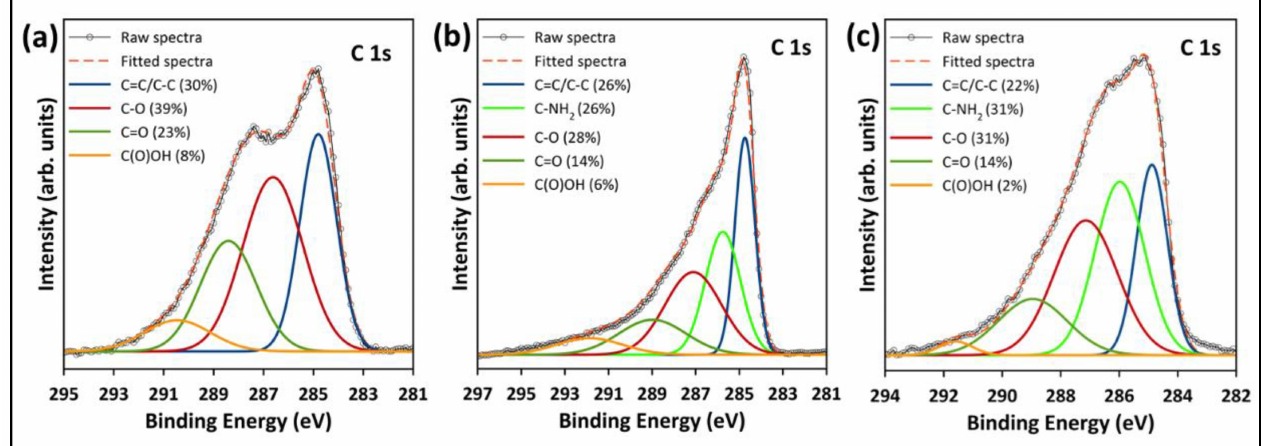
Figure 10. High-resolution XPS deconvolution of C 1s for ( a ) the pristine GO, ( b ) rGO-TEPA1, and ( c ) rGO-TEPA2.